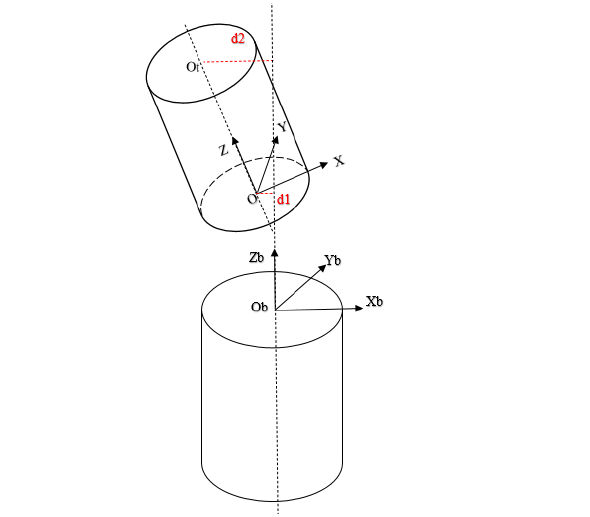
Figure 4. Schematic diagram of coaxiality